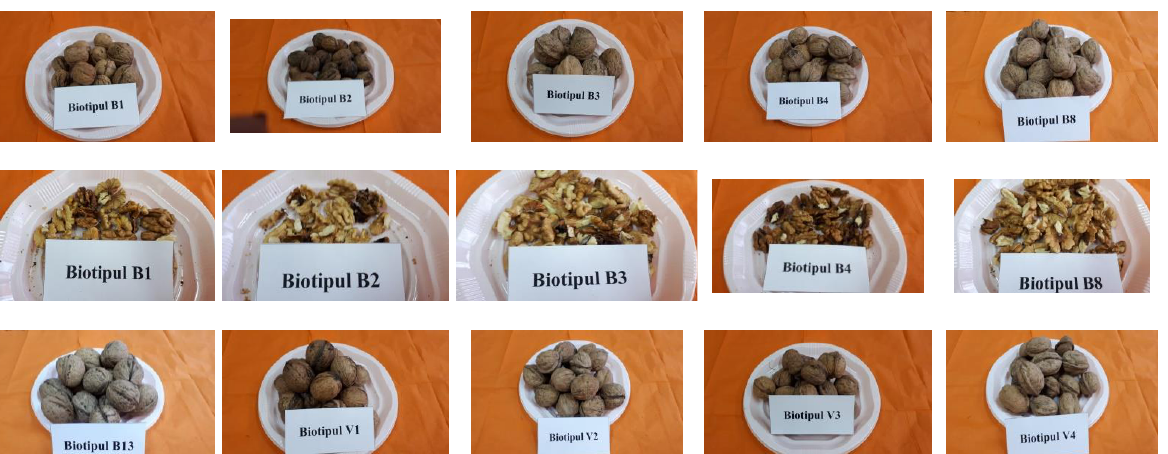
Figure 1. The walnut genotypes from west and north-west of Romania. 2.2. Physical Analysis The following physical properties of the walnut were studied: in-shell walnut dimen- sions and shape properties (walnut diameter, walnut length and walnut size), fruit prop- erties (weight of whole walnut, weight of walnut kernel and percentage of walnut kernel)